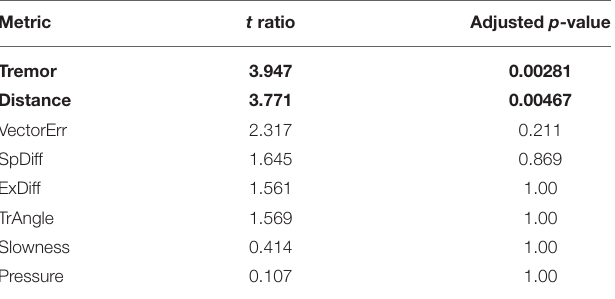
TABLE 3 | Comparison of metric weights between patients with PD and patients with